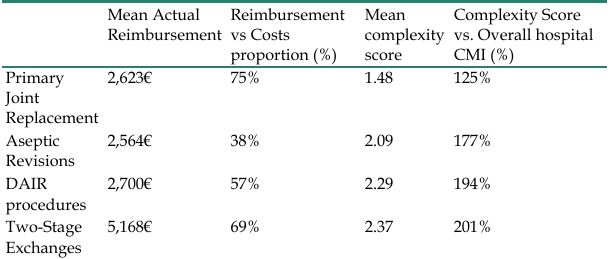
Table 5. Comparison between calculated costs and actual reimbursement for each group (TKA and THA considered